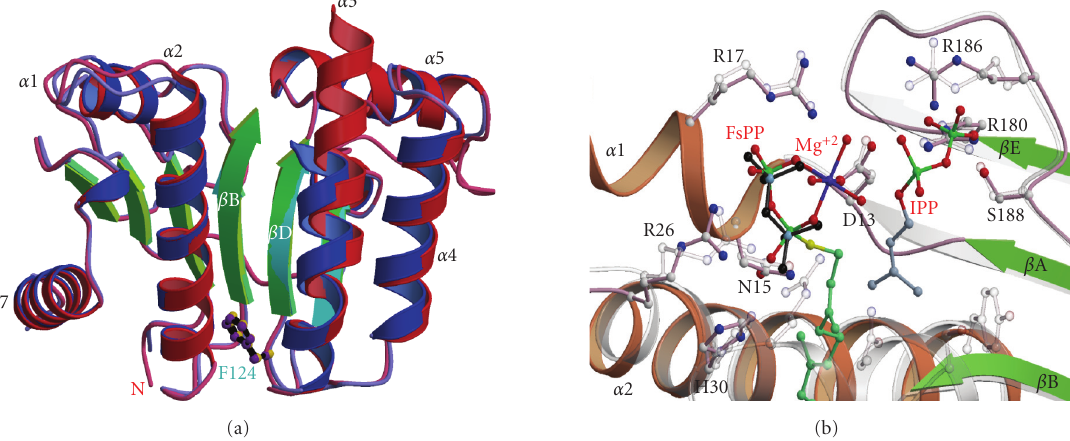
Figure 1: Crystal structures of H. pylori UPPS. (a) Two subunits of the apoenzyme are superimposed. The most obvious disposition occurs in α 3 helix which adopts an open form and a closed form in subunit A and B, respectively. At the top of the tunnel-shaped crevice surrounded by 2 α -helices and 4 β -strands is the substrate-binding site. Phe124 located at the bottom of the H. pylori UPPS tunnel adopts a similar position to that of Leu137 in E. coli UPPS, essential for determining product chain length. (b) Superimposition of active site structures of H. pylori UPPS with FsPP and E. coli UPPS with FsPP, Mg 2+ , and IPP [9]. The active site residues in H. pylori UPPS are shown in pink and those in E. coli UPPS in white for carbon-carbon bonds in ball-and-stick model. The thiopyrophosphate (visible in crystal structure) is shown in black, the nitrogen atoms and Mg 2+ ion are shown in blue, and oxygen atoms are shown in red. Asp13 in H. pylori UPPS occupies a similar position to that of Asp26 in E. coli UPPS to coordinate with an Mg 2+ for binding with the pyrophosphate leaving group of FPP.